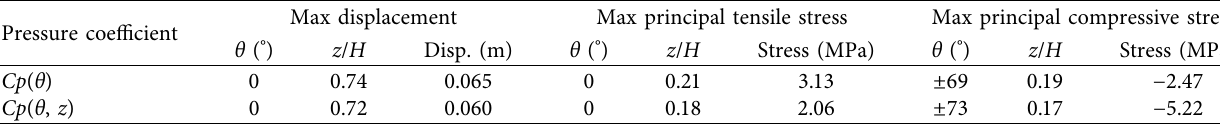
Figure 11: Comparison of meridional stress at typical height. Table 1: Comparison of max response.